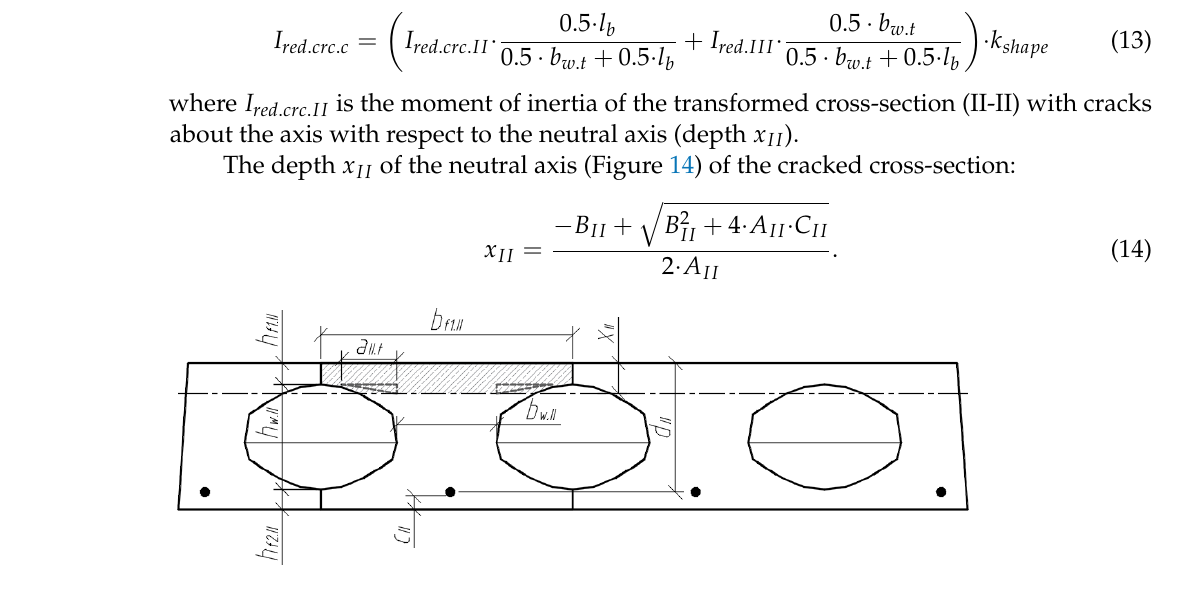
Figure 14. Cracked cross-section within section II-II, when x II > h f 1. II .